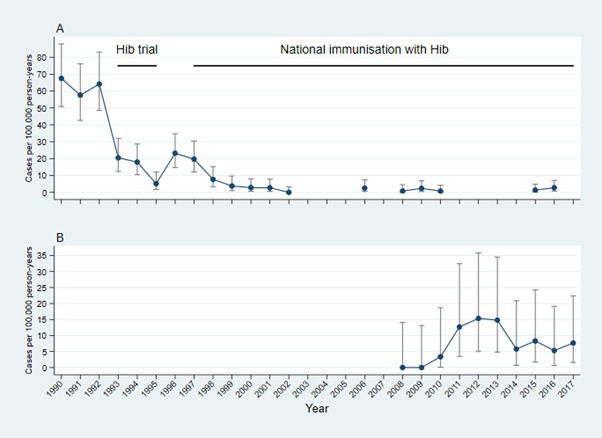
Incidence of Haemophilus influenzae type b (Hib). Panel A. Incidence of Haemophilus influenzae type b (Hib) meningitis in children under 5 years of age in the West Coast Region using conventional microbiology, 1990-2016. Panel B. Incidence of Hib disease in children aged 2-59 months in the Basse Heath and Demographic Surveillance System, 2008-2017.